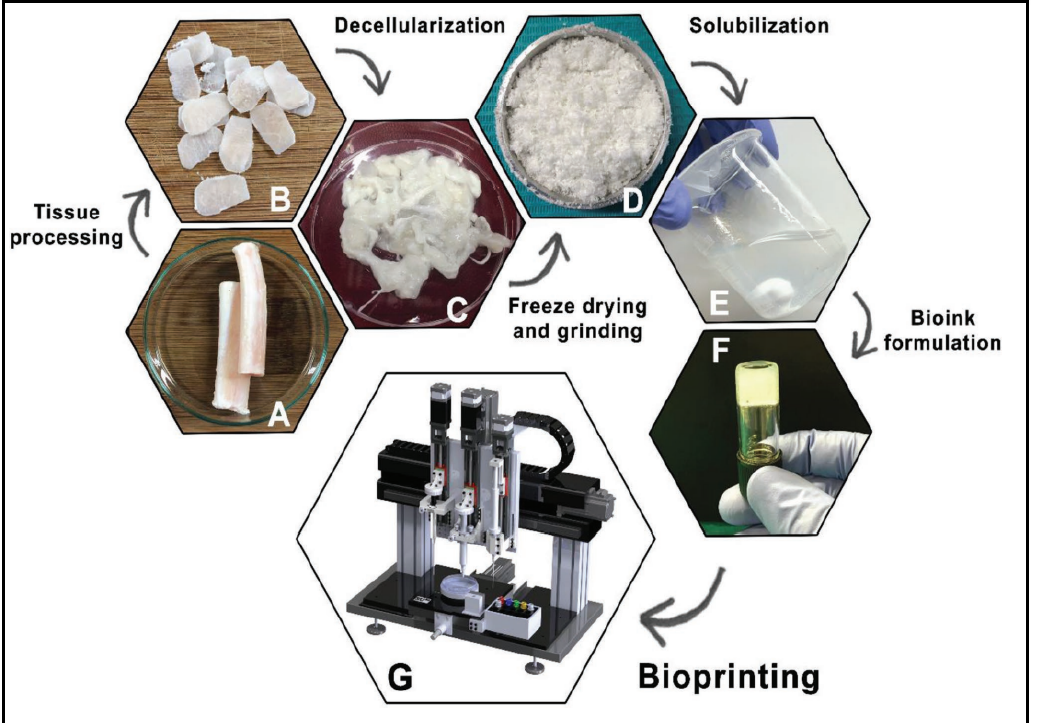
Figure 9. General steps to obtain a dECM bioink. Native tissue ( A ), Processed tissue ( B ), Decellularized tissue ( C ), Freeze-drying and grinding ( D ), Solubilization ( E ), Bioink formulation ( F ), Bioprinting ( G ). Reproduced with permission [73].